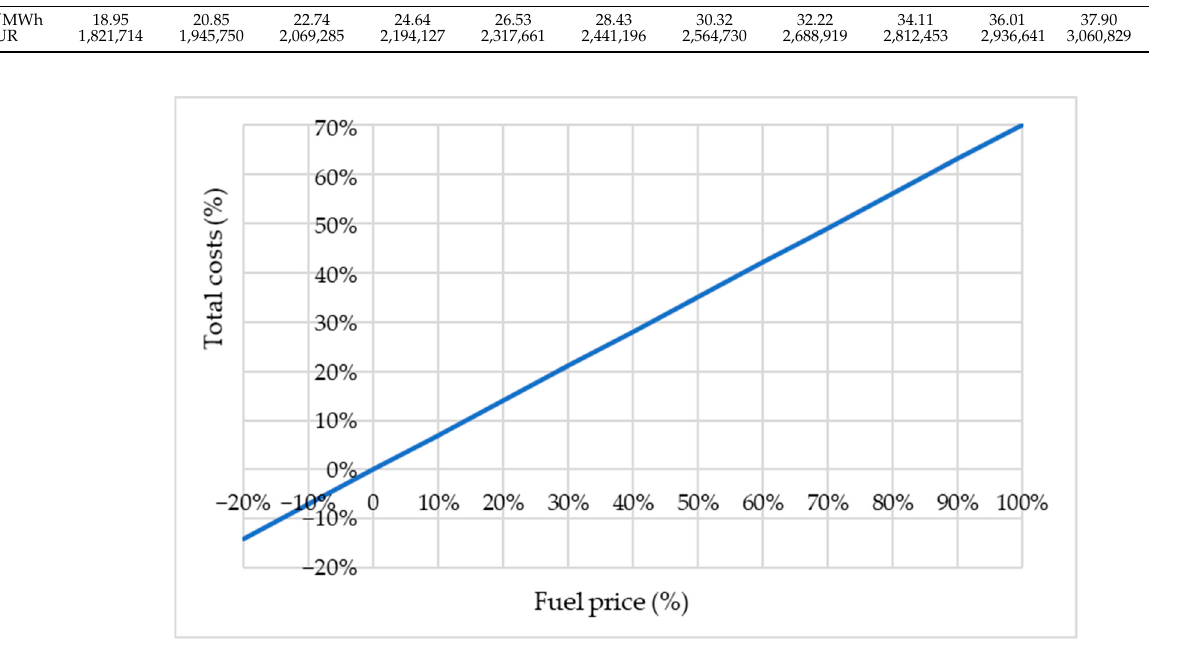
Table 5. Summary results for a 60% increase in the fuel price.